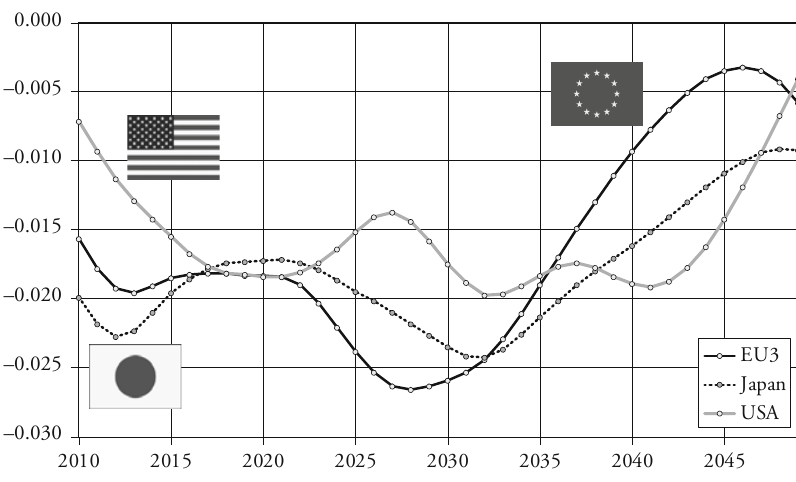
Figure 2: The macroeconomic challenge: Annual percentage loss of workers per population,